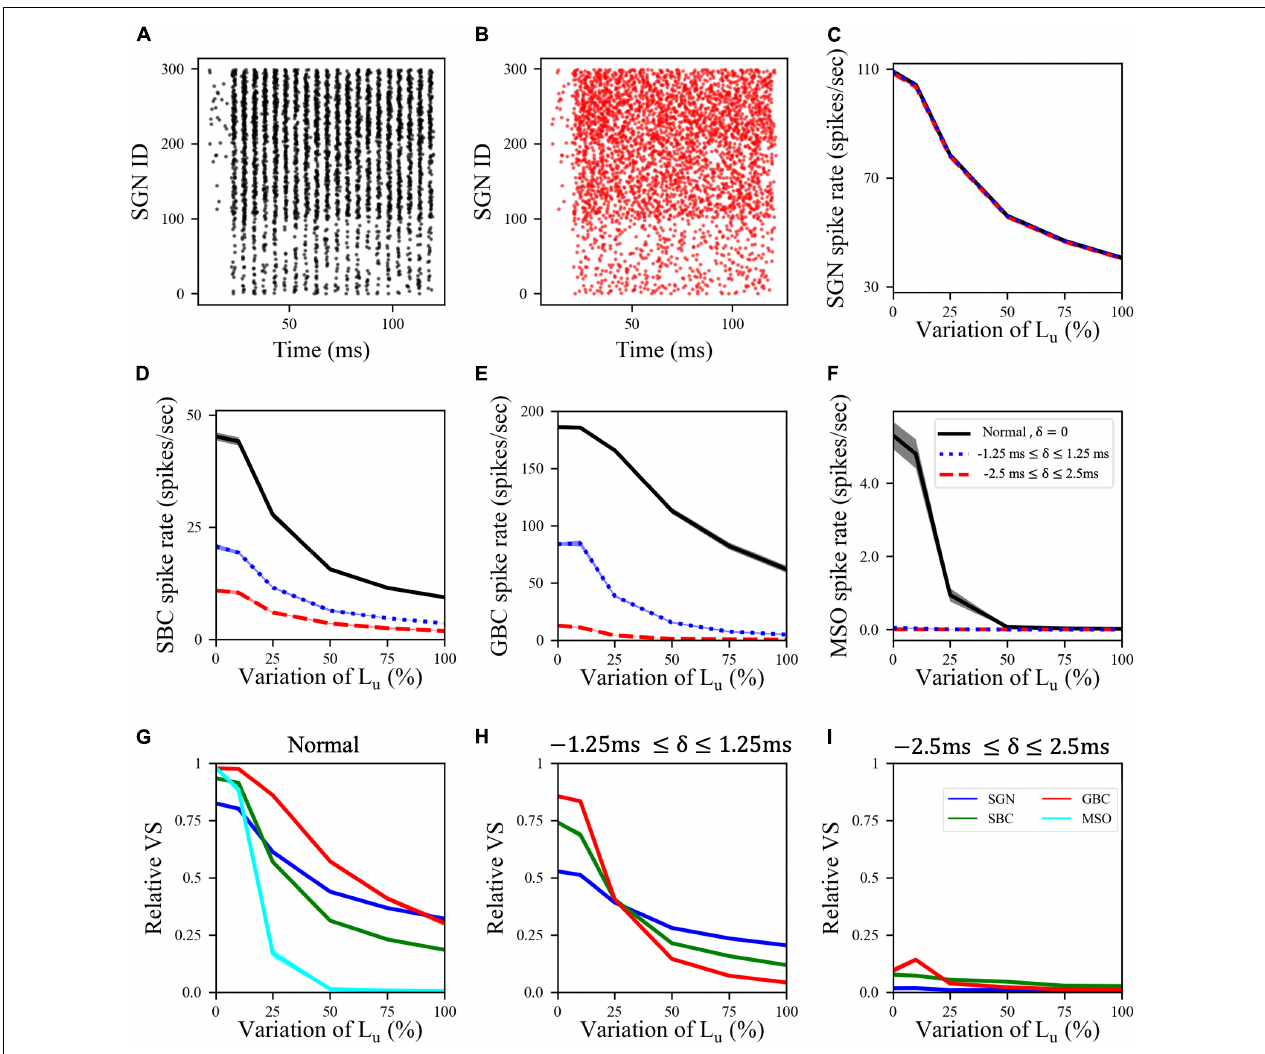
FIGURE 3 | Synchronized synaptic input from SGN cells was necessary to maintain activity rates in downstream cell populations. (A) Raster plot showing the activity of a normal SGN population in response to 200 Hz, 50 dB sound stimulus. (B) Raster plot where the spike times shown in panel (A) are randomized by adding a jitter δ varying between –2.5 and 2.5 ms (high jitter case) to the SGN spike times in panel (A) . (C) SGN, (D) SBC, (E) GBC, and (F) MSO spike rates for low (–1.25 ms ≤ δ ≤ 1.25 ms) and high jitter and L u variation levels. Here, 0% variation of L u represents a circuit with a homogeneous population of SGNs with 10 µ m long L u and 100% variation of L u represents a circuit with a heterogeneous SGN population with 10 µ m ≤ L u ≤ 20 µ m. (G–I) Relative VS of all cell populations at all myelinopathy levels with (G) normal (same figure as Figure 2D ), (H) low jitter and (I) high jitter SGN inputs. Increasing randomization of SGN spikes decreased spike rates and relative VS of all cell types at all myelinopathy levels. Note that there is no cyan line in panels (H,I) due to no MSO cell firing in low jitter and high jitter cases (dotted-blue and dashed-red lines in panel (F)